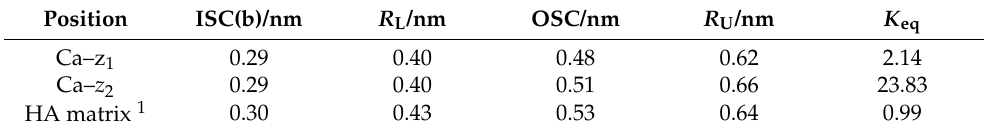
Table 1. Ca 2+ –C COO RDF characteristic positions of the first and second maxima, ISC(b) and OSC, re- spectively; first and second minima, R L and R U , respectively; and complex distribution constant K eq . Position ISC(b)/nm R L /nm